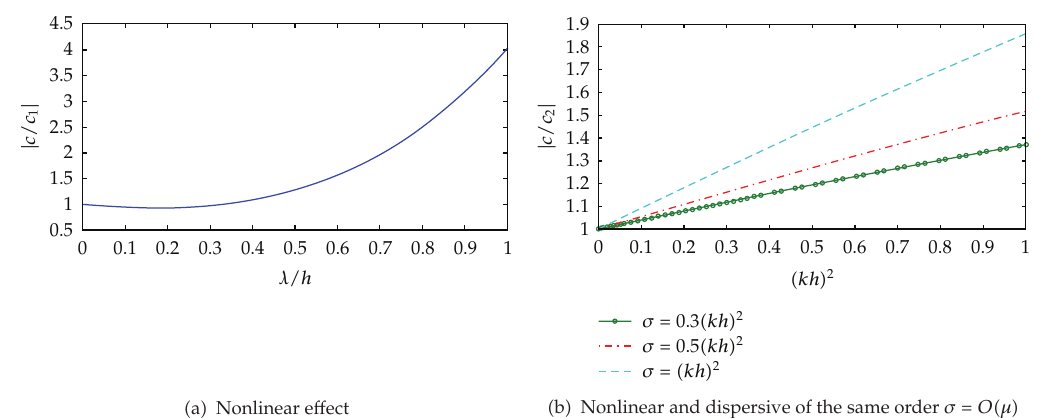
Figure 3: Quotient of wave celerity for two formulations. In the case (cid:2) a (cid:3) , only nonlinear e ff ect was simulated. In the case (cid:2) b (cid:3) , the dispersive and nonlinear have the same order σ (cid:7) O (cid:2) μ (cid:3) .